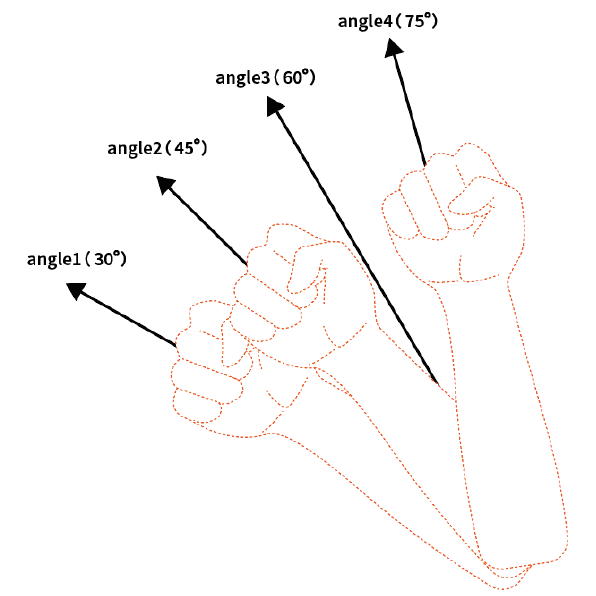
Figure 3. Forearm angle. Three forearm angles were selected, which were 30°, 45° and 75°.